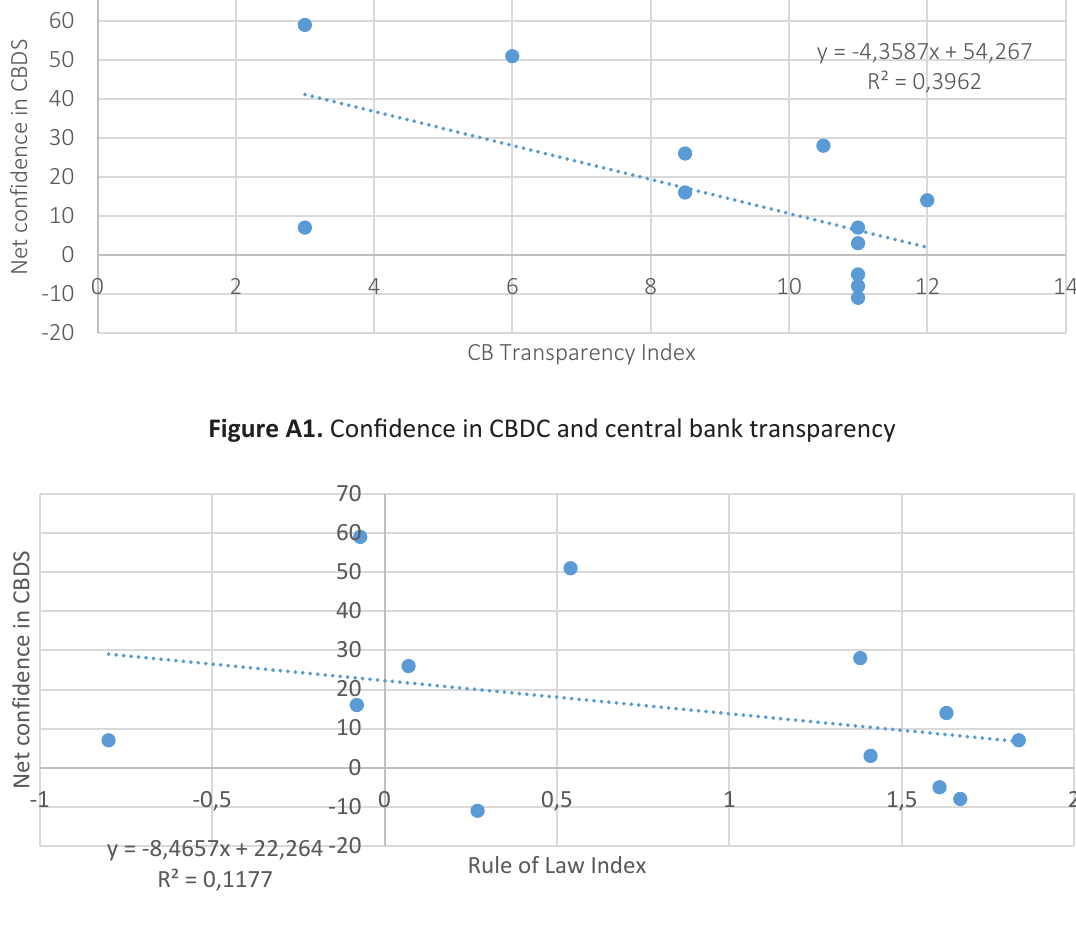
Figure А2. Confidence in CBDC and the rule of law